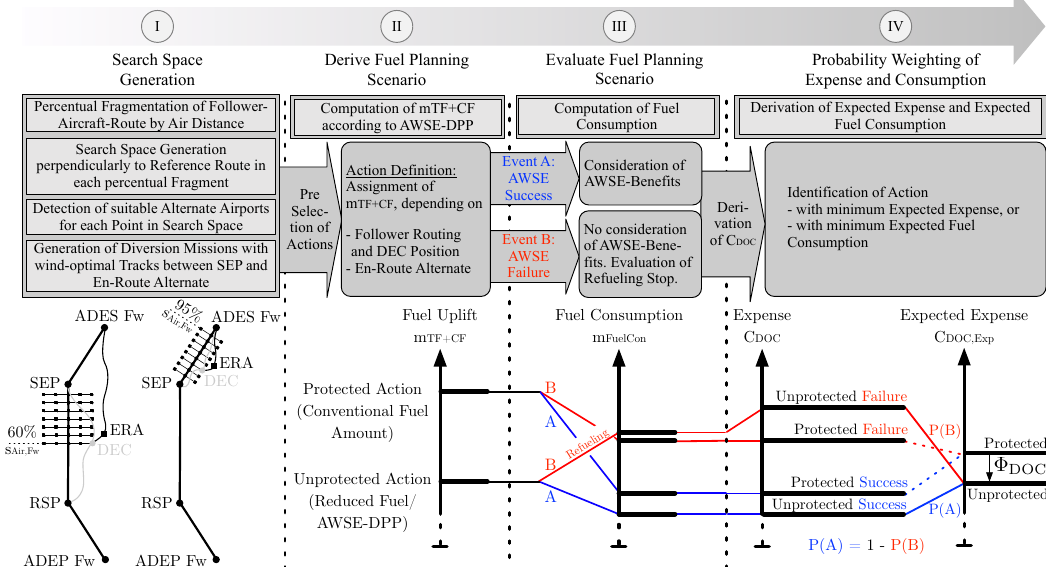
Figure 2. Proposed workflow for optimized flight planning with AWSE-DPP, subdivided into Step I to IV. Based on assumed values P(A) for AWSE success probability, the depicted event tree between Step II and IV shows exemplarily the derivation of the expected expense and the resulting savings potential Φ DOC of an AWSE-DPP action in comparison to a conventional